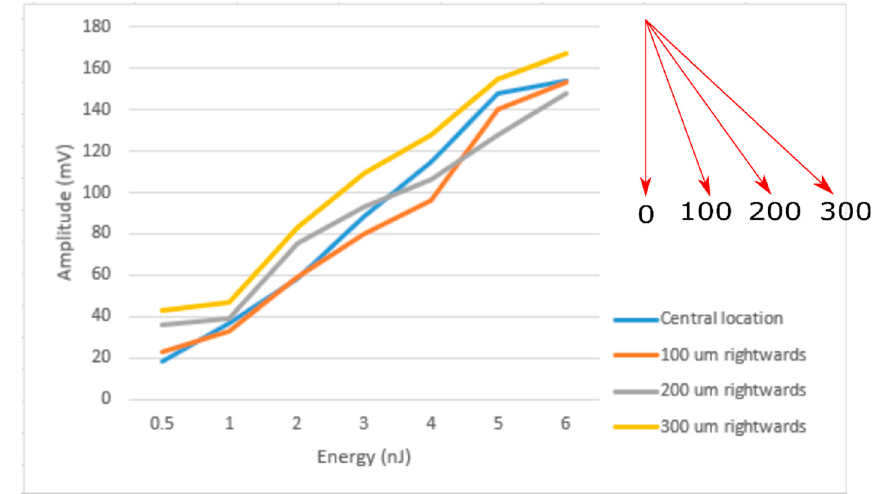
Figure 9. Injected angle effect via different offset distance.